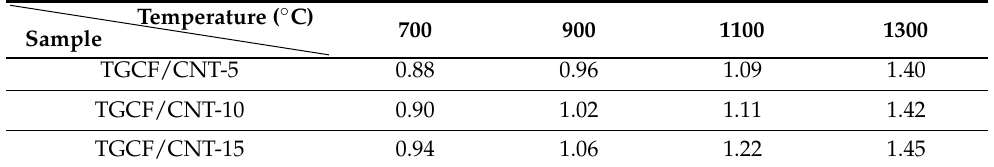
Figure 5. Raman spectra of TGCF/CNT carbon papers obtained according to various carbonization temperatures and CNT contents. Table 2. Ratio of graphitic to defect structures in TGCF/CNT carbon papers (i.e., ratio of heights of G and D peaks in Figure 5).